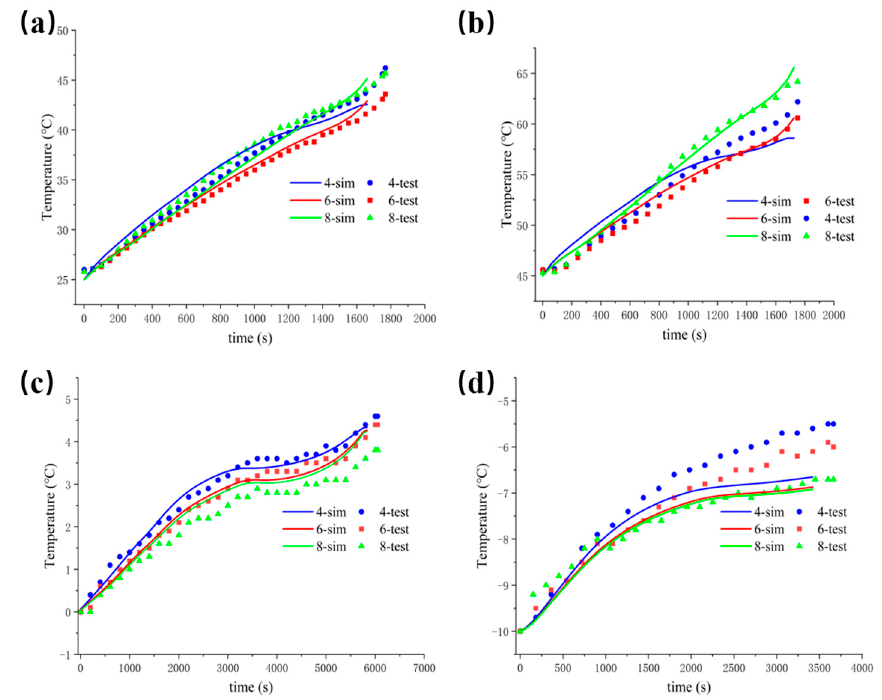
Figure 7. The 3D model midline temperature validation for different charging conditions. ( a ) 25 °C 2 C; ( b ) 45 °C 2 C; ( c ) 0 °C 0.5C; ( d ) − 10 °C 0.5 C.